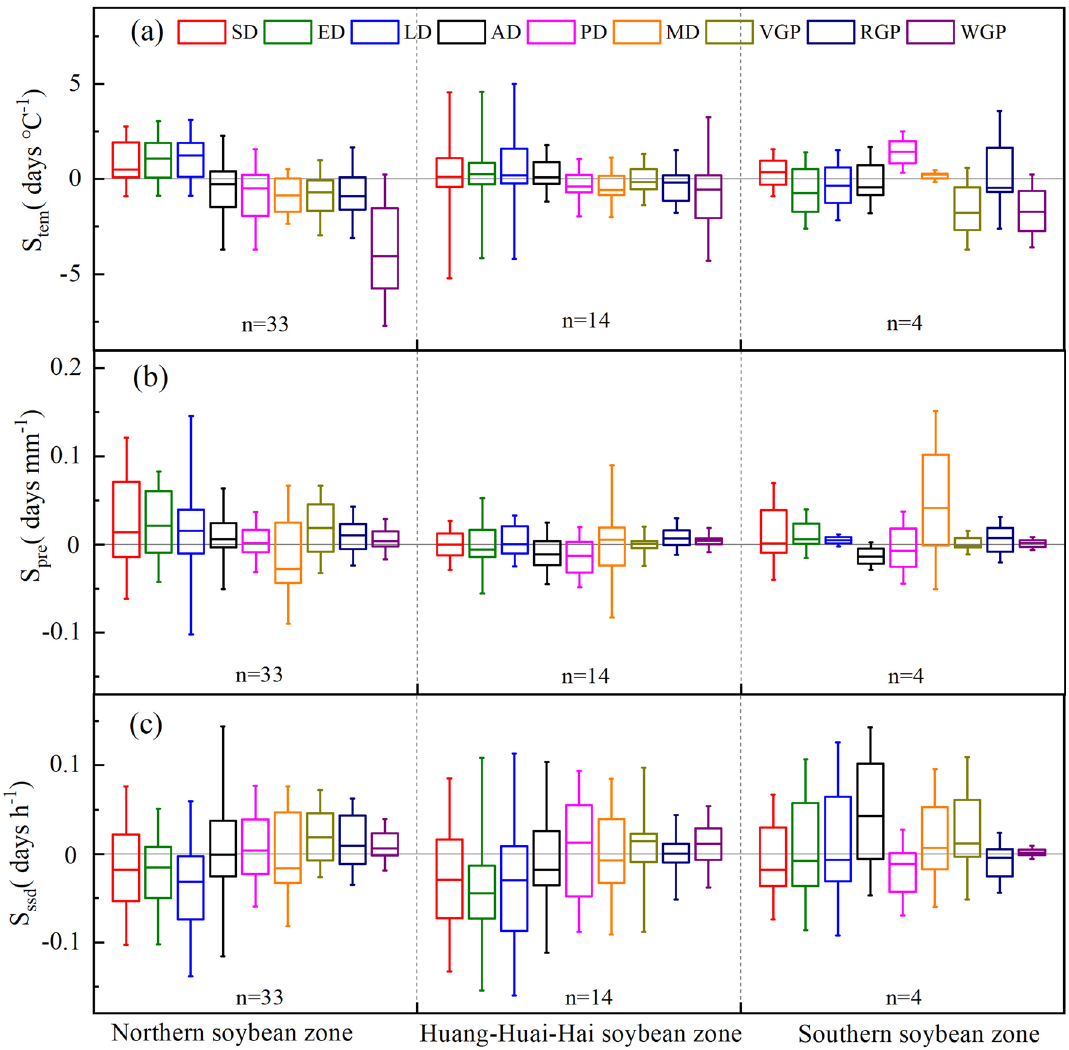
Figure 5. The sensitivity of soybean phenology to key climatic factors from 1992 to 2018 in China. The abbreviations are the same as in figures